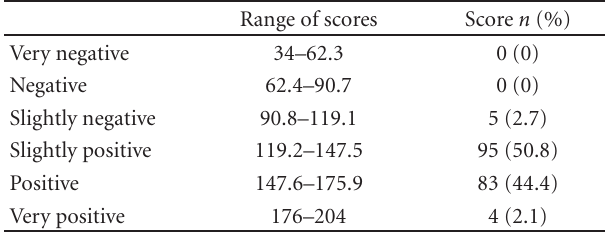
Table 3: Kogan’s attitudes towards older people scale scores.